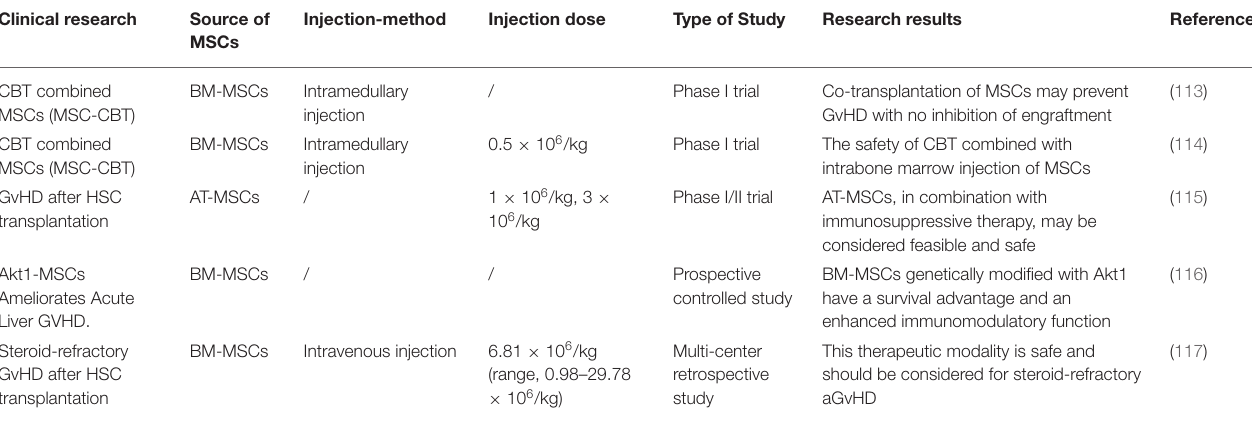
TABLE 1 | The application of MSCs in